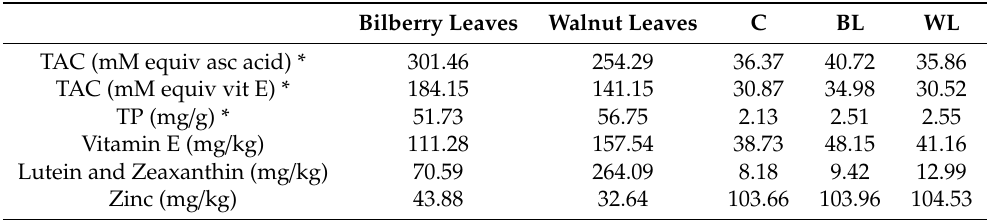
Table 2. The oxidative stability-influencing parameters of dietary supplements and experimental diets. Bilberry Leaves Walnut